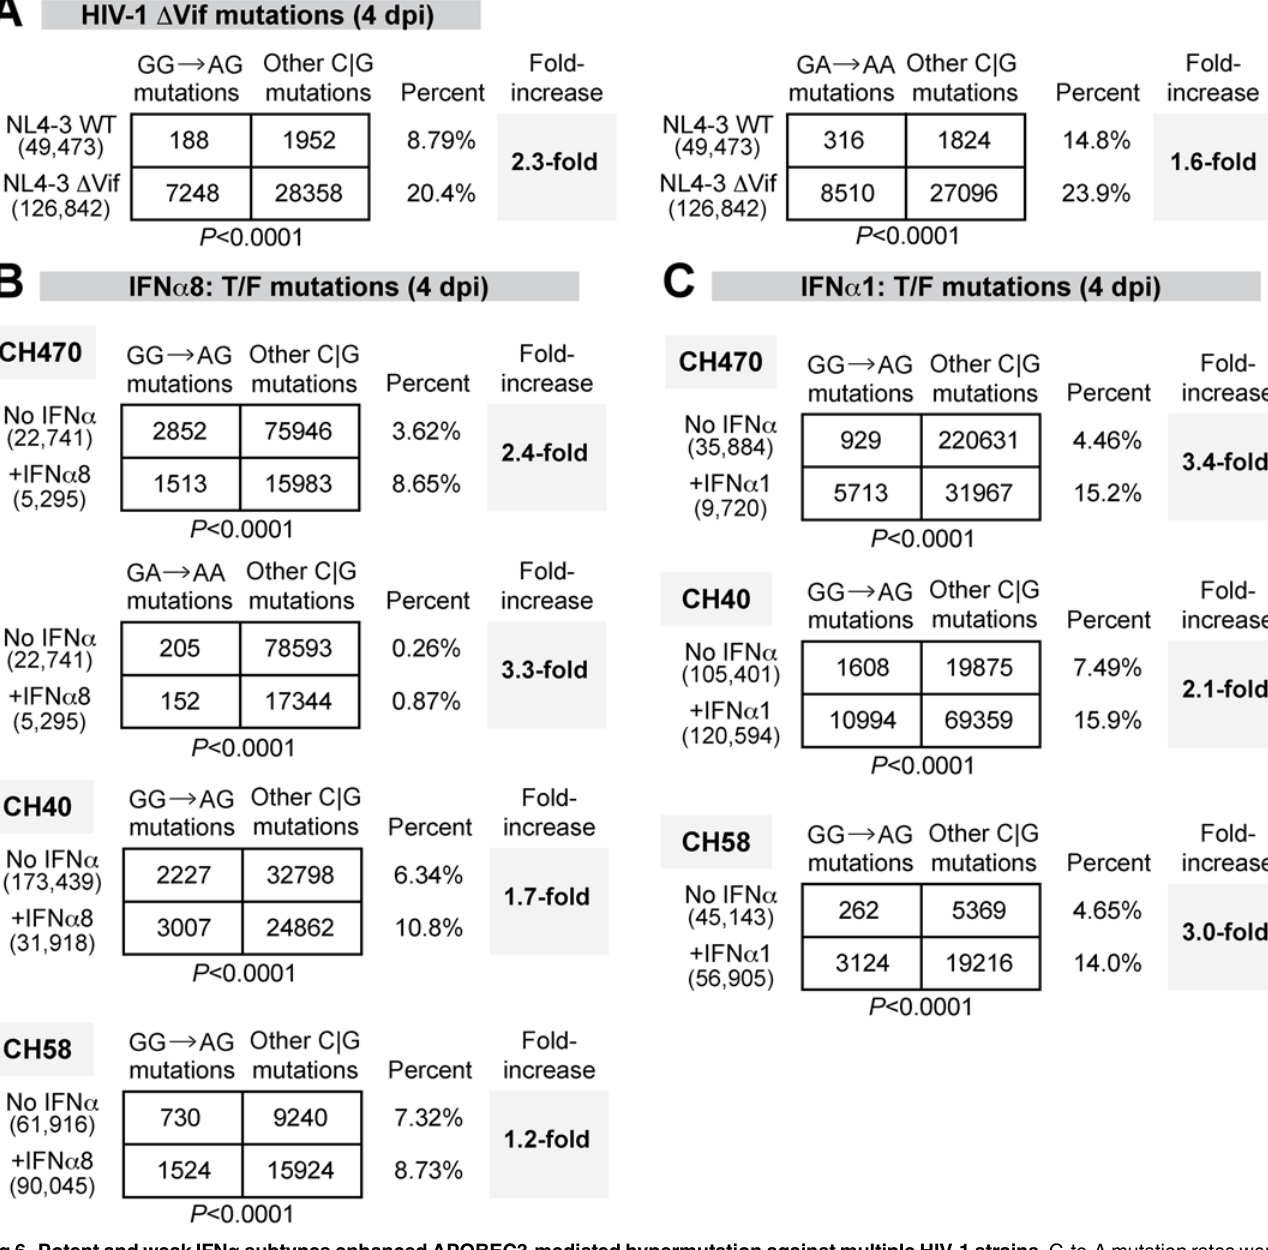
Fig 6. Potent and weak IFN α subtypes enhanced APOBEC3-mediated hypermutation against multiple HIV-1 strains. G-to-A mutation rates were estimated for (A) HIV-1 NL4-3 WT versus Δ Vif infected LPMCs at 4 dpi; T/F strains infected LPMCs with or without (B) IFN α 8 or (C) IFN α 1 (100 pg/ml) treatment at 4 dpi. For all panels, DNA was extracted from HIV-1 infected cells or tissues and a 420 – 450 bp HIV-1 gp41/nef region was amplified using barcoded Illumina primers. Each sequence analyzed was represented at least twice per donor. Sequence reads from multiple donors were pooled for each virus condition. The number of sequence reads analyzed was shown in parentheses. The percentage of the respective mutations relative to the total number of C or G mutations were shown, and the fold-increase relative to the (A) WT or (B, C) no-treatment control were shown in bold. Differences in the proportions of GG ! AG or GG ! AA mutations relative to other C or G mutations between the treatment groups were analyzed using a 2×2 contingency test with Yates ’